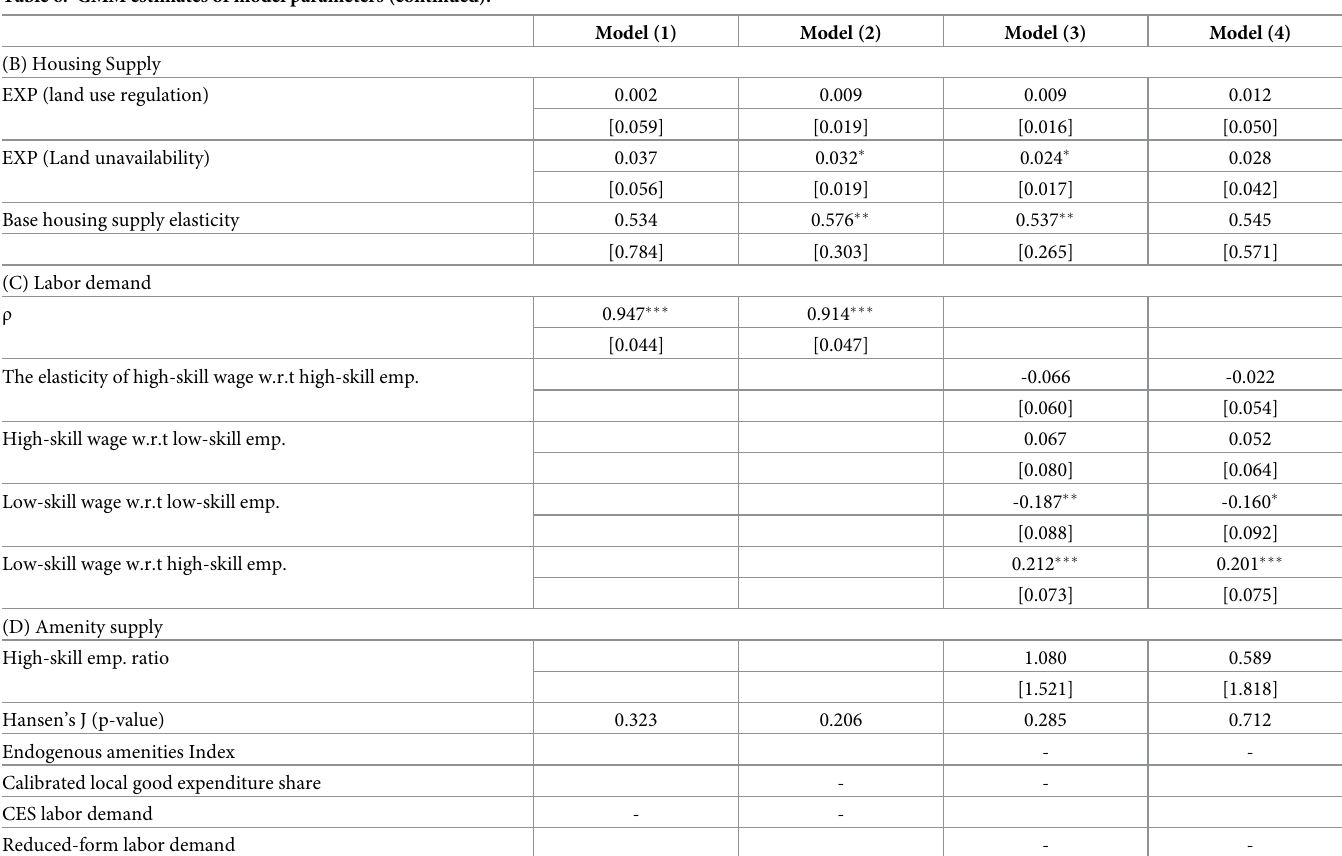
Table 6. GMM estimates of model parameters